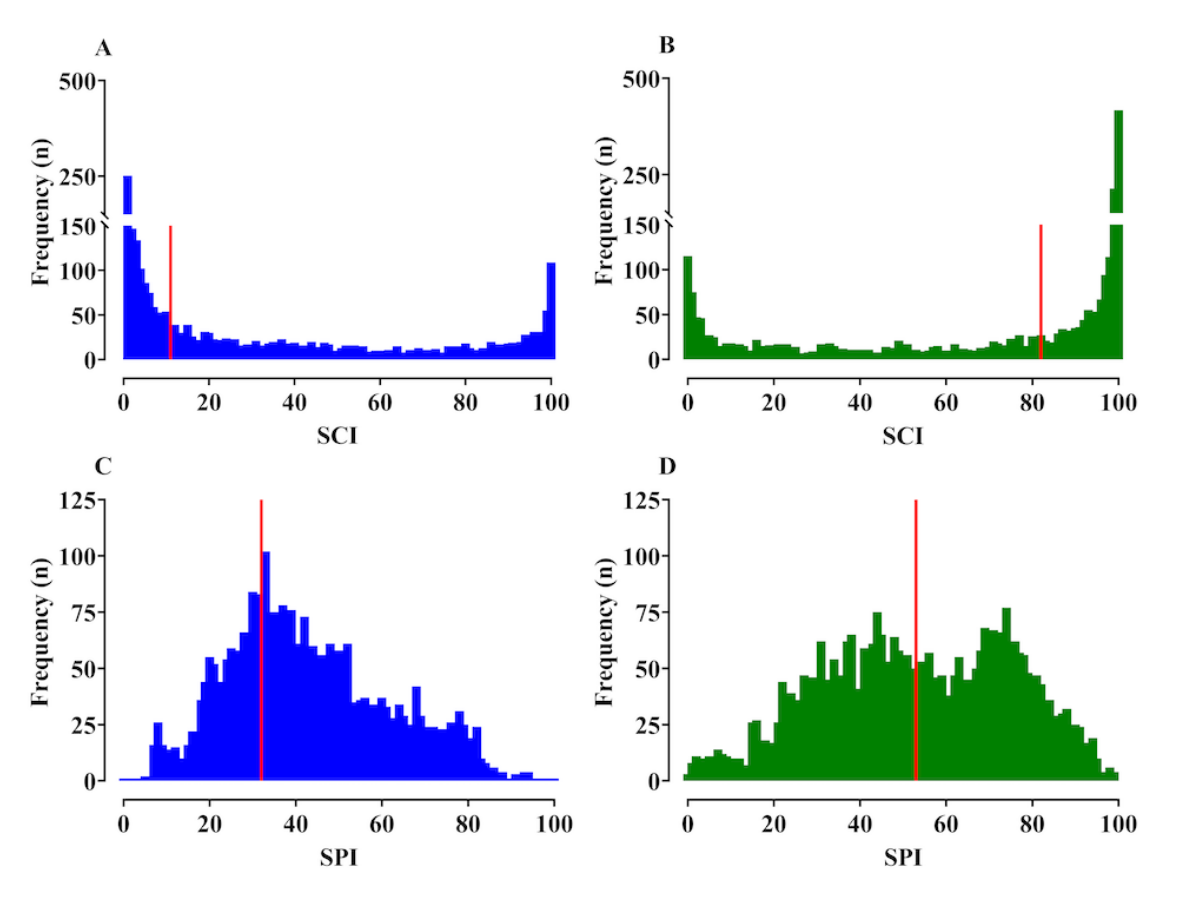
Figure 5. Frequency distribution of the spectrogram-convolutional neural network index (SCI, A and B) and surgical pleth index (SPI, C and D) values observed without (A and C) and with (B and D) pain. During the data collection period (baseline: 5 min, postanaesthesia care unit: 5 min), the SCI and SPI values were observed every 10 sec. The vertical red lines show the median frequency (A: 11, B: 82, C: 32, D: